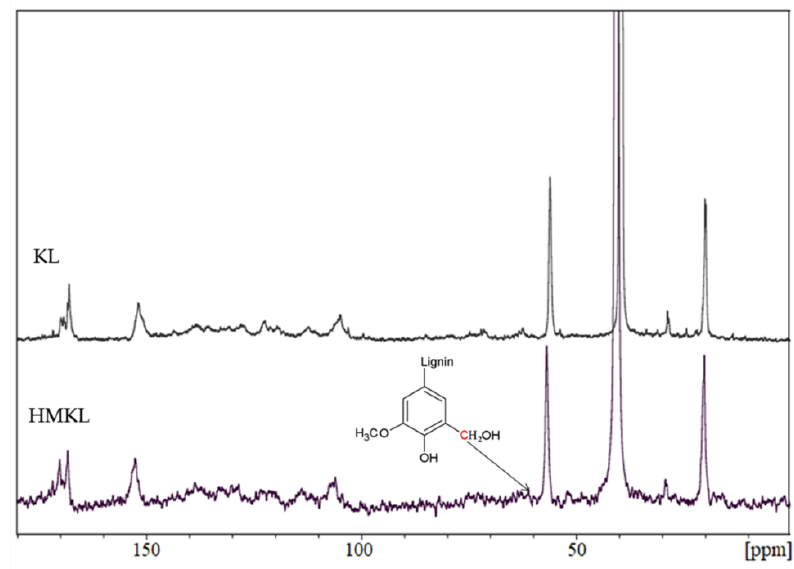
Figure 4. 13 C NMR spectra of unmodified KL and HMKL.